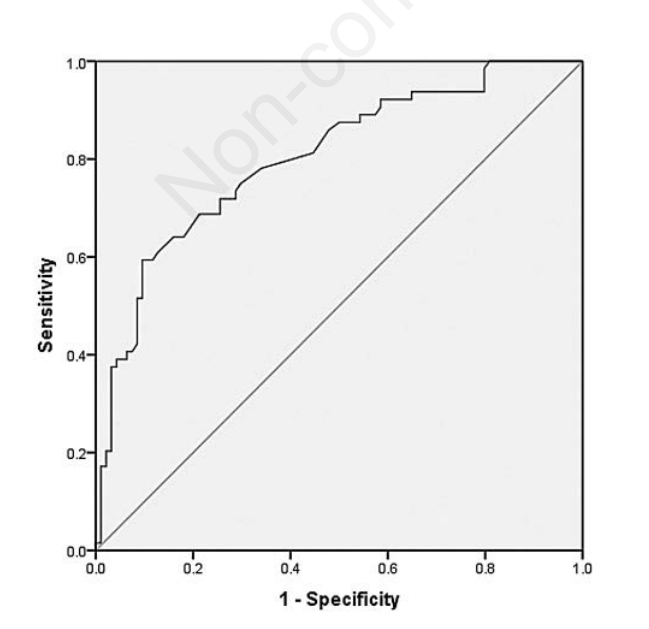
Figure 2. ROC curve of diagnosis of NTDT by RDW from the training set. RDW, red cell distribution width; NTDT, non-transfusion-dependent thalassemia; ROC, receiving operating